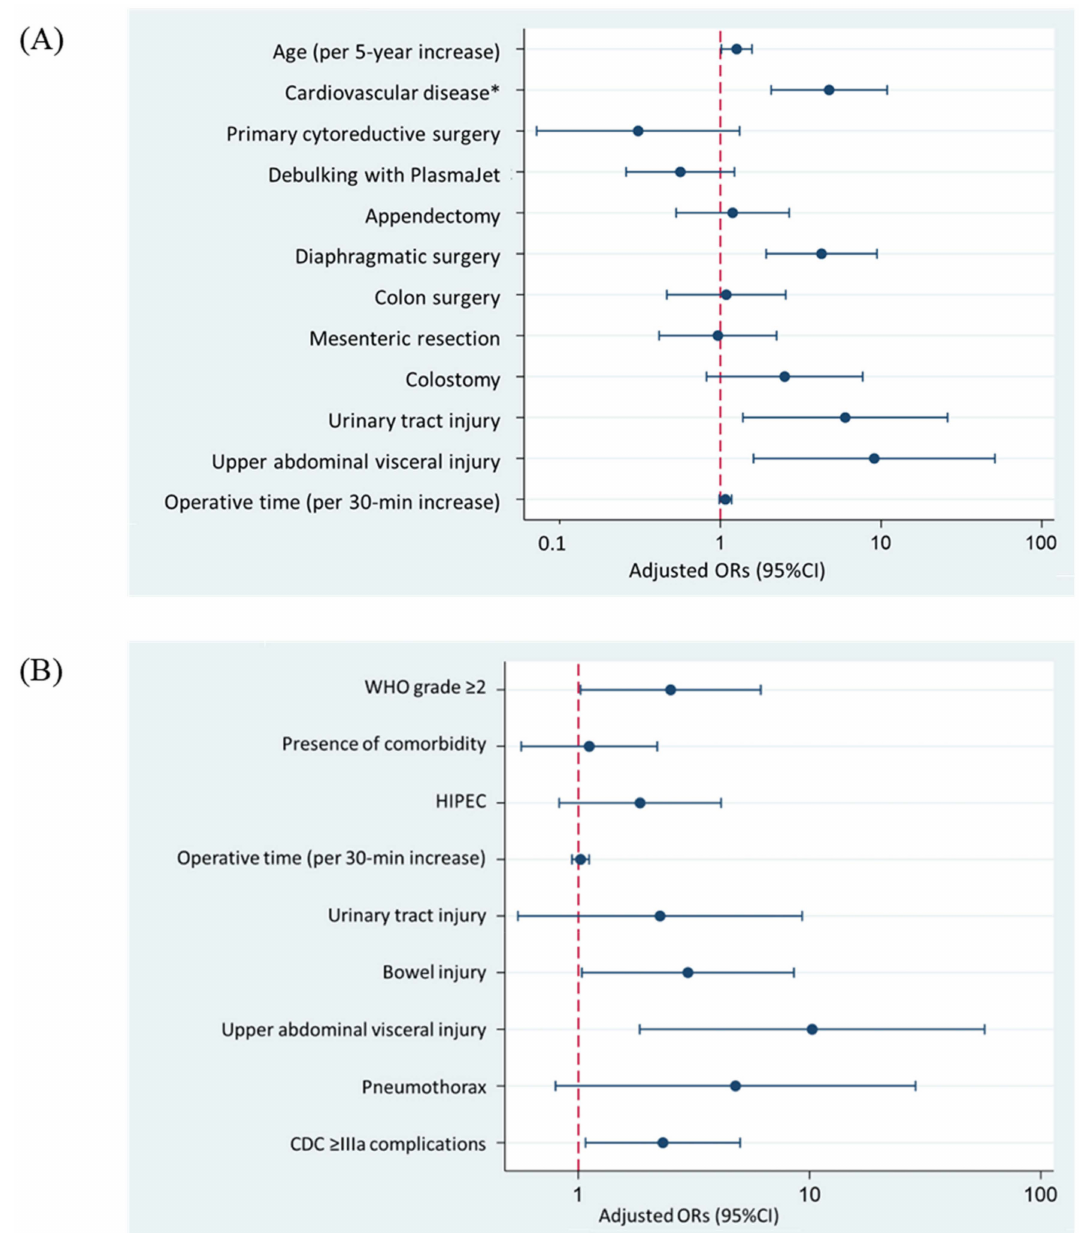
Figure 2. ( A ) Factors related to Clavien–Dindo classification ≥ IIIa complications. ( B ) Factors related to time to initiating adjuvant chemotherapy >42 days. * Cardiovascular disease was defined as any of the following: myocardial infarction, stroke, and peripheral vascular disease. WHO: World Health Organization, HIPEC: hyperthermic intraperitoneal chemotherapy, CDC: Clavien–Dindo